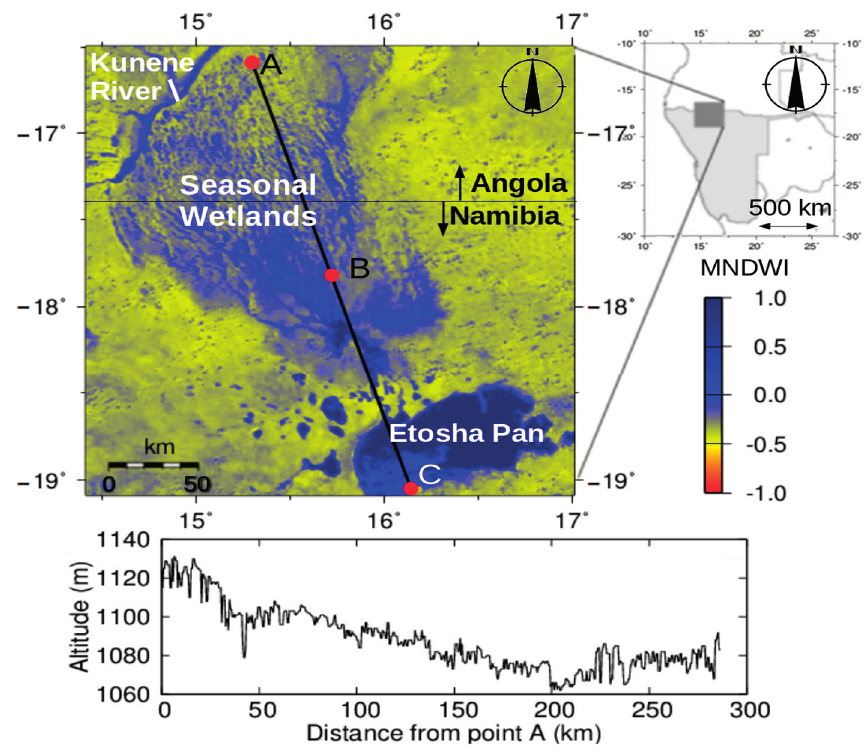
Figure 2. (Top) The study region and (bottom) the altitude profile along the transect from the Angolan Plateau shown in the map. The transect was drawn along the seasonal river drainage pathway. The profile was created from global 30-arc-second elevation (GTOPO30) data [5]. On this basis, we calculated the average bed slope. Three test sites, distributed at equal distances along the transect, were used to determine the correlation between the modified normalized-difference water index (MNDWI) and the normalized-difference polarization index (NDPI): A (15°17 ʹ 59 ʺ E, 16°35 ʹ 23 ʺ S) represents the Angolan Plateau, B (15°43 ʹ 20 ʺ E, 17°49 ʹ 09 ʺ S) represents the center of the seasonal wetlands, and C (16°08 ʹ 40 ʺ E, 19°02 ʹ 54 ʺ S) represents the Etosha Pan. The background image is the MNDWI distribution derived from MODIS data (24 March